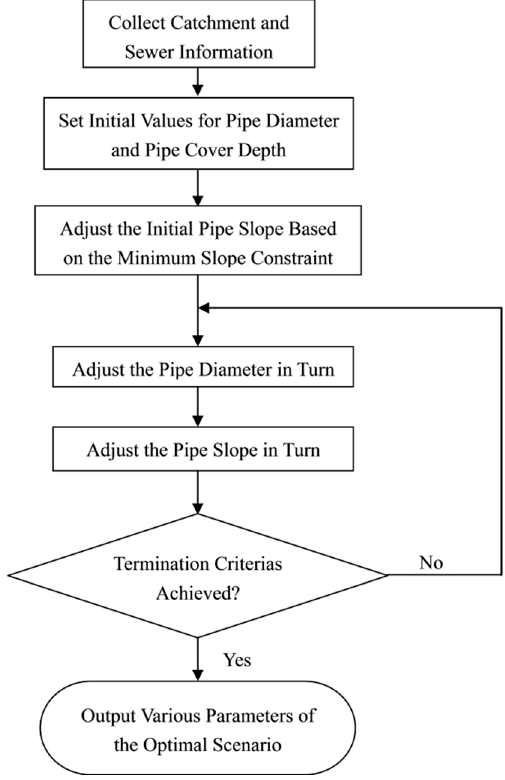
Figure 2. Schematic description of the proposed algorithm based on Storm Water Management Model (SWMM).